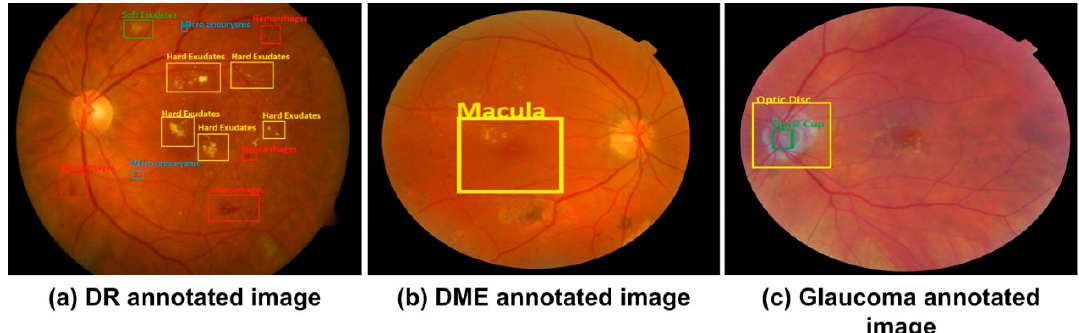
Figure 2. Sample annotated images for all three diseases. ( a ) represents the image annotations for DR signs/objects i.e., microaneurysms, soft exudates, hard exudate, hemorrhages. ( b ) represents the DME sign (macula) ( c ) represents the image annotations for Glaucoma i.e., OC and OD.